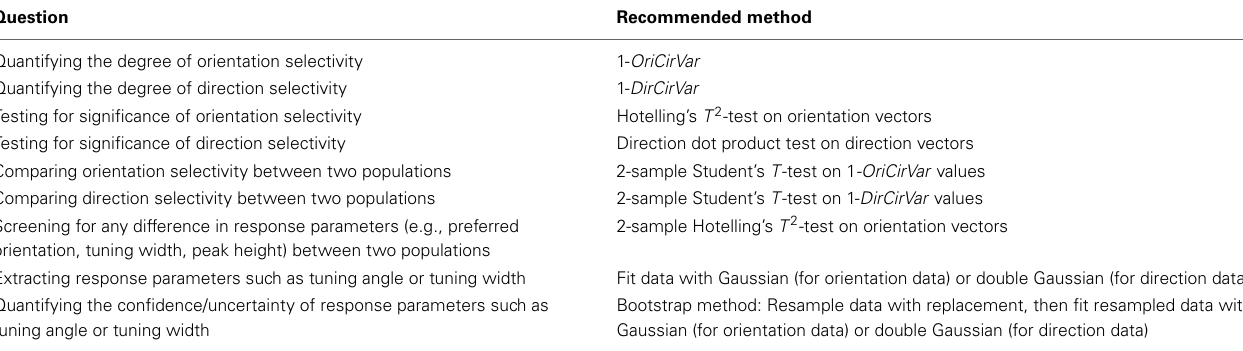
Table 2 | Recommended methods for answering several common scientific questions involving orientation and direction